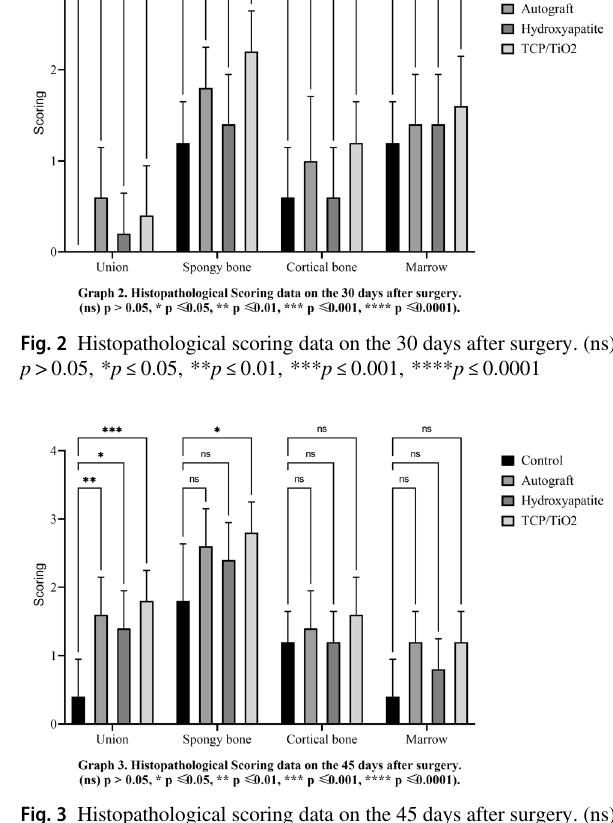
Fig. 3 Histopathological scoring data on the 45 days after surgery. (ns) p > 0.05, * p ≤ 0.05, ** p ≤ 0.01, *** p ≤ 0.001, **** p ≤ 0.0001